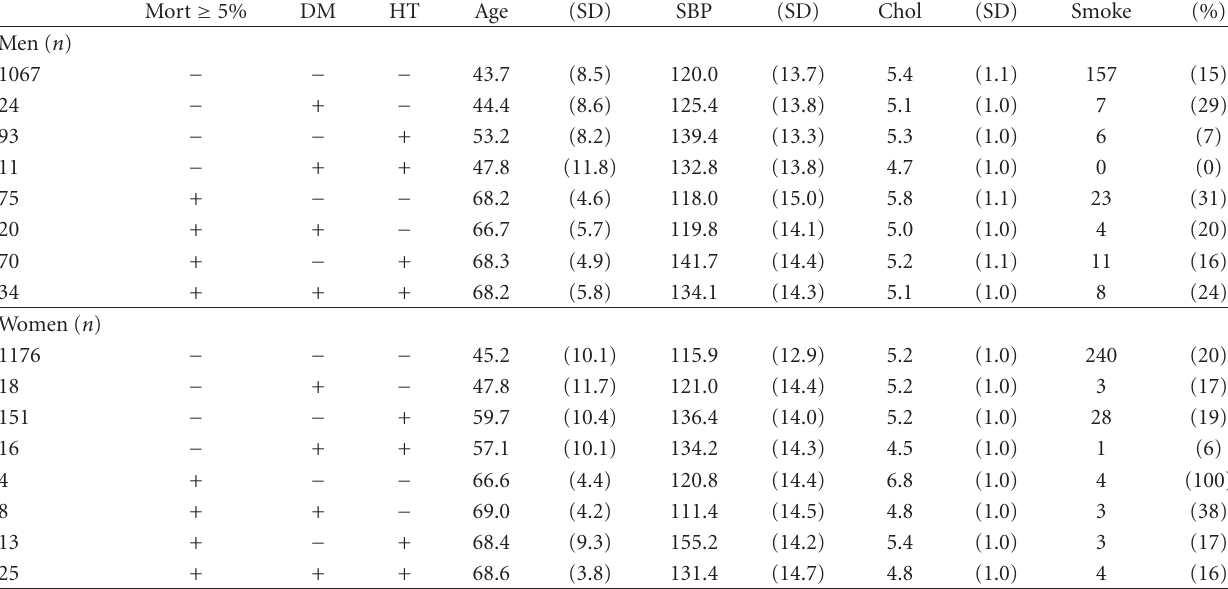
Table 3: Global risk according to SCORE characterized by SCORE variables in men and women of the Vara-Sk¨ovde Cohort in the Skaraborg Project